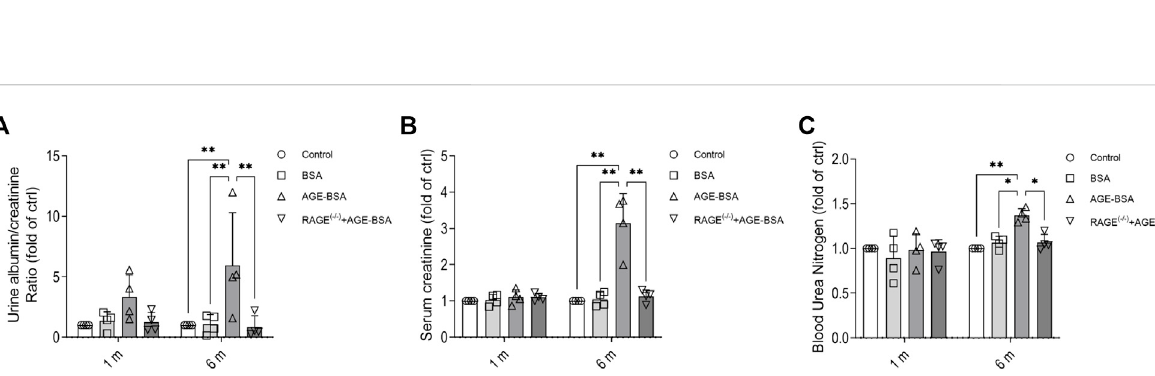
inhibited in AGE-BSA-treated RAGE ( − / − ) mice, suggesting again that RAGE plays an important role in AGE-induced kidney malfunction.